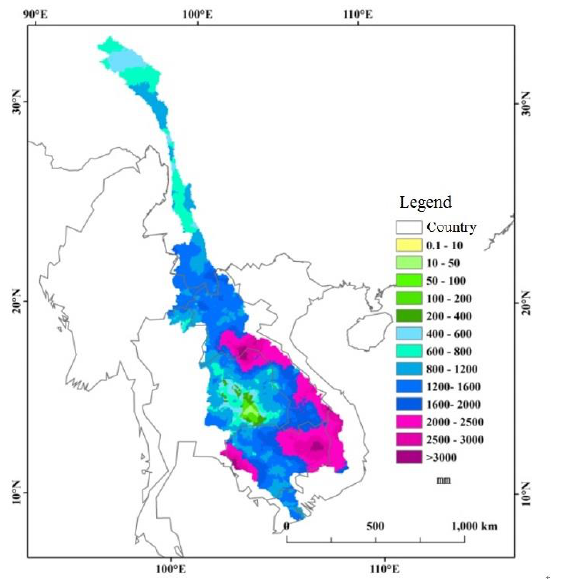
Figure 5. Precipitation of Mekong River Basin from2013.06 to 2014.05